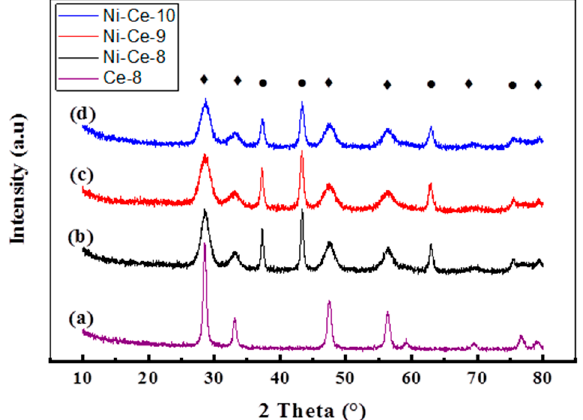
Figure 2. XRD patterns of Ni-Ce-pH catalysts calcined at 600 °C: ( a ) Ce-8; ( b ) Ni-Ce-8; ( c ) Ni-Ce-9; and ( d ) Ni-Ce-10. ♦ CeO 2 , ● NiO. Table 2. Results obtained from the structural characterization of Ni–Ce catalysts by XRD.